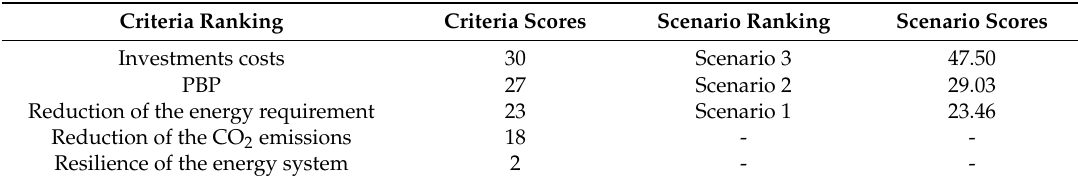
Table 2. Final ranking of the decision criteria and alternative scenarios.